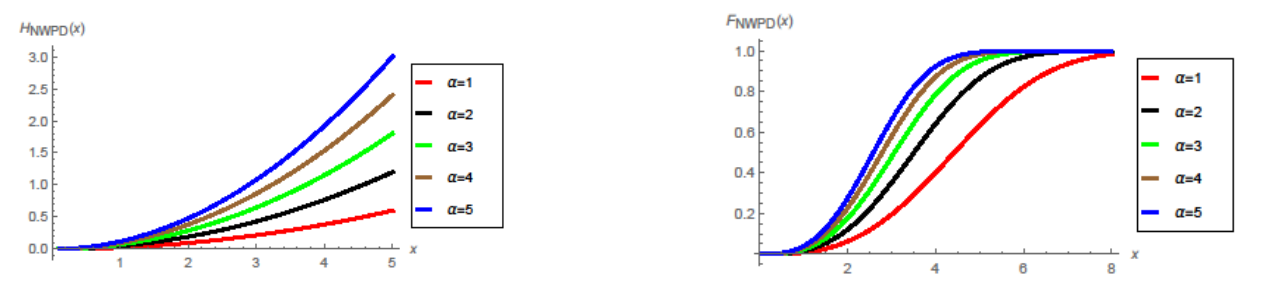
Figure 1. The pdf and reliability function of the NWPD with 2, 4  = = .